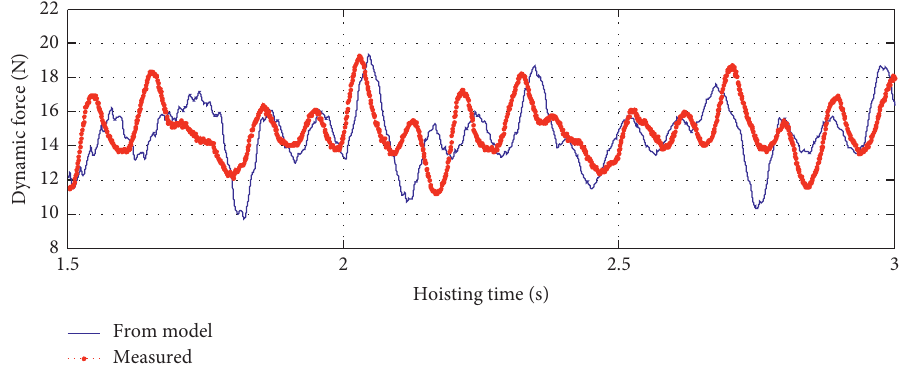
Figure 13: Enlarged view of the dynamic forces at the conveyance end of the